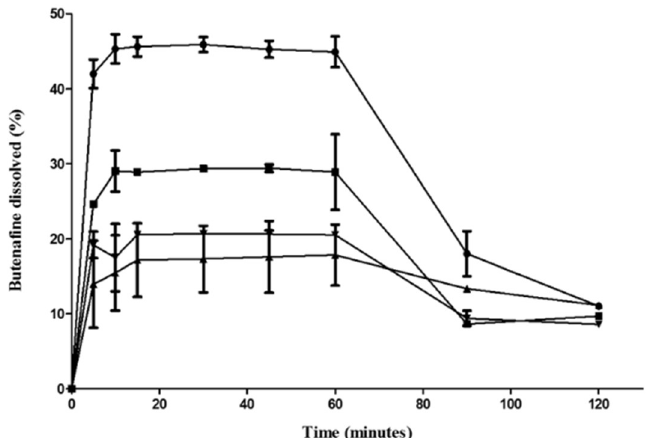
Figure 2. Release of solid B-SNEDDS formulations in simulated gastric fluid (SGF) (pH 1.2, first 60 min) and simulated intestinal fluid (SIF) (pH 6.8) thereafter (mean % ± SD). -●- F1, - ■ -F2, - ▲ - F3, - ▼ - F4.